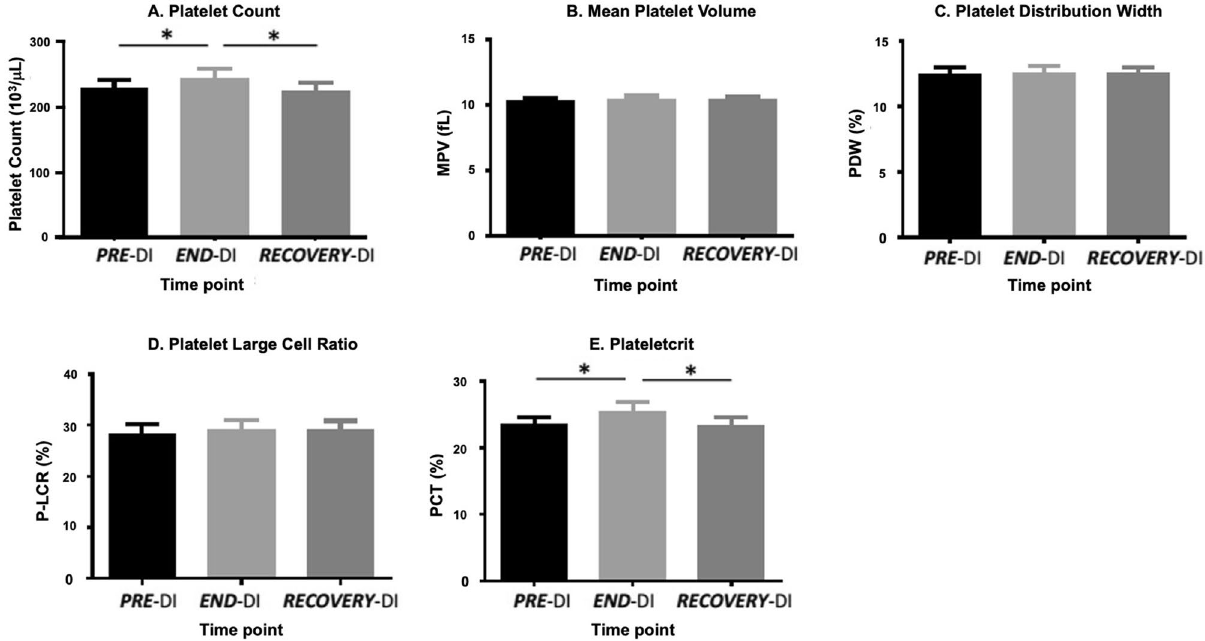
Figure 2. Effect of dry immersion and physical inactivity on platelet indices. Graphs represent the mean ± SEM of each parameter at each time point. ( A ) Platelet count, ( B ) Mean Platelet Volume, ( C ) Platelet Distribution Width, ( D ) Platelet Large Cell Ratio and ( E ) Plateletcrit. * P < 0.05. Paired samples t-test and repeated measures ANOVA (adjusted for age, BMI and VO 2; n = 12, biological